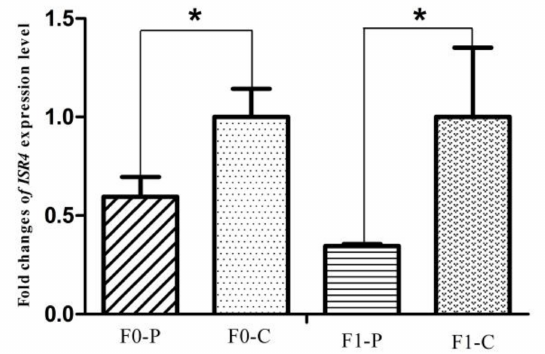
Figure 11. Fold change of glucose metabolism gene, ISR4 , expression level between P (paternal inheritance group) and C (control group) in the F0 and F1 generations. * indicates p <